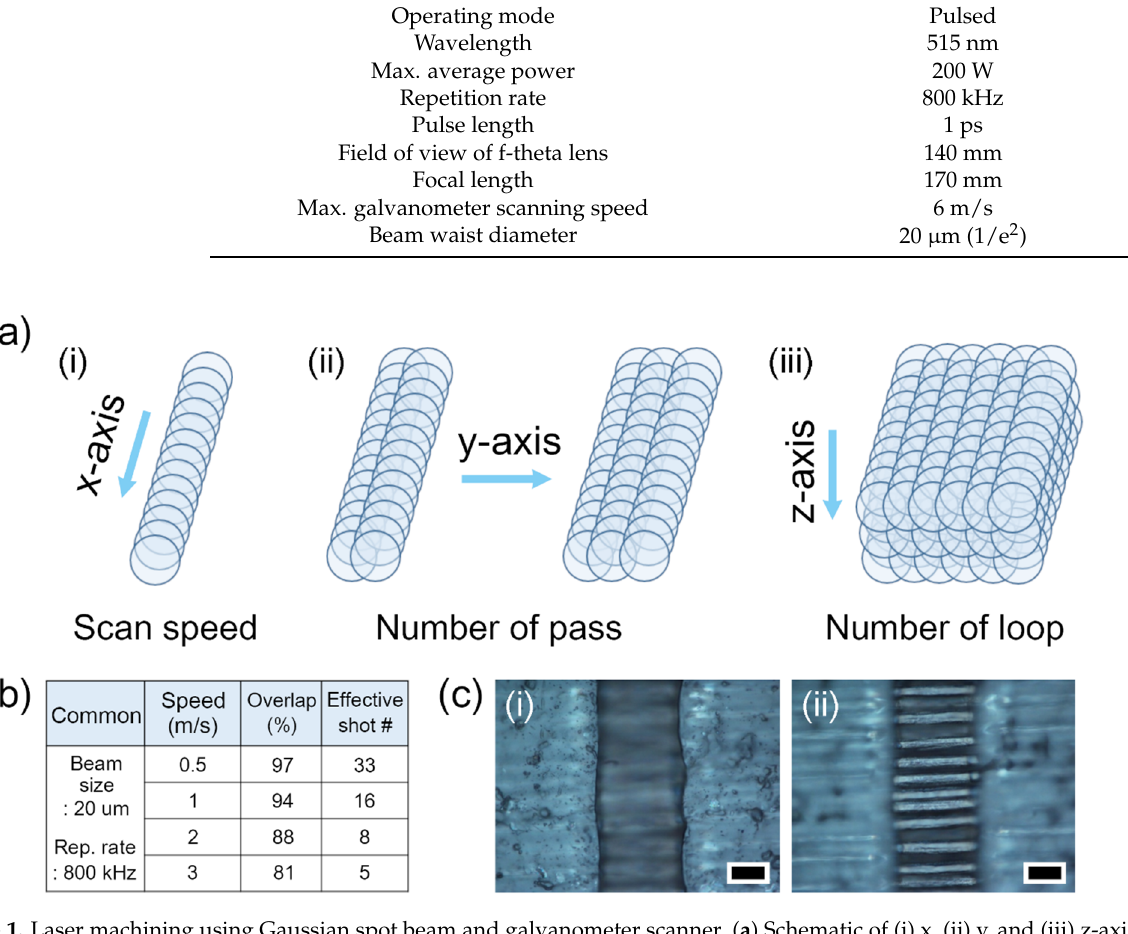
Figure 1. Laser machining using Gaussian spot beam and galvanometer scanner. ( a ) Schematic of (i) x, (ii) y, and (iii) z-axis scanning using laser spot beam. Main experimental parameters with a scan speed, the number of passes, and the number of loops corresponding to movement of each axis. One loop means a cycle with the number of passes in lateral direction. ( b ) Relationship between the beam size, the repetition rate, the scan speed, beam overlap, and effective shot numbers per area. ( c ) Optical microscope images of laser-machined carbon fiber reinforced polymer (CFRP) surface. The images indicate (i) top surface and (ii) carbon fiber bundles at a deeper focus position. Each scale bar = 20 µm.